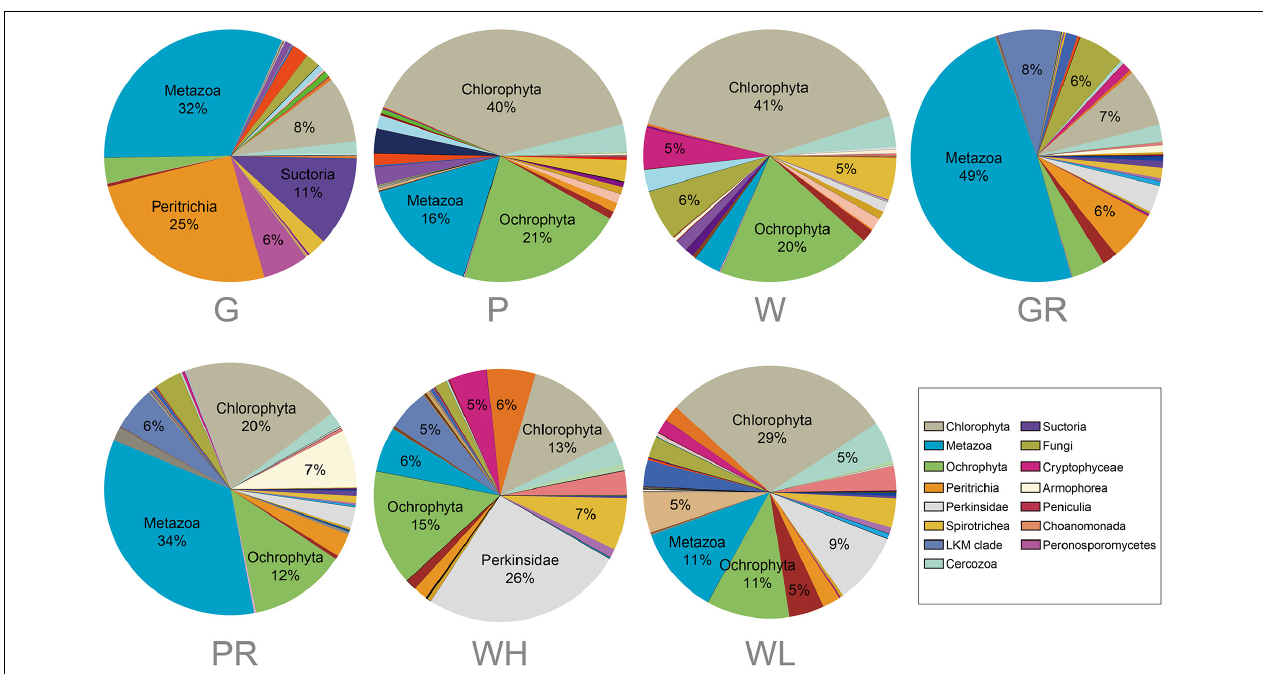
FIGURE 7 | Comparison of taxonomic profile of microeukaryotic OTUs among different sample types from the lake and river. Samples are named as follows: G, glass slides in Ming Lake; P, PFUs in Ming Lake; W, water columns in Ming Lake; GR, glass slides in Pearl River; PR, PFUs in Pearl River; WH, water columns at high tide in Pearl River; WL, water columns at low tide in Pearl River. The relative abundance of each group > 5% is shown. Abundant groups represented by > 10% of each taxonomic unit were labeled with group name, and the relative abundance of each group > 5% was labeled with percentage in pie